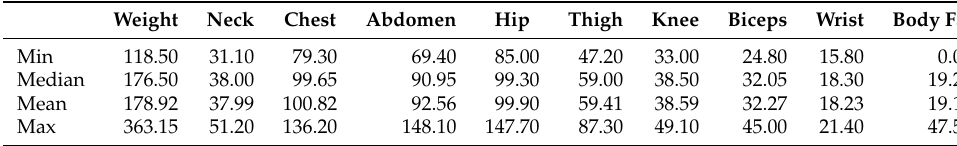
Table 13. Descriptive statistics for Body Fat Prediction data.